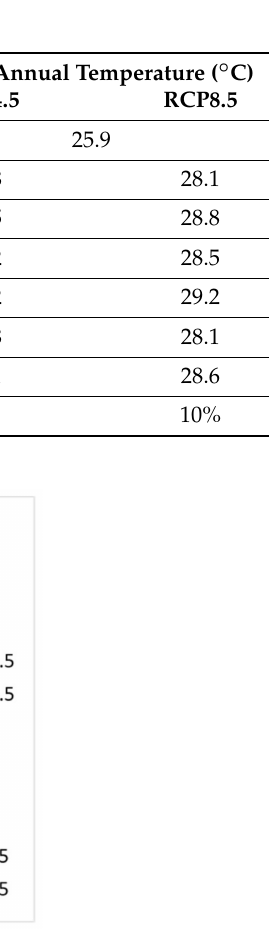
Figure 3. Boxplot of mean annual precipitation (mm/year) for each GCM and scenario (RCP4.5 and